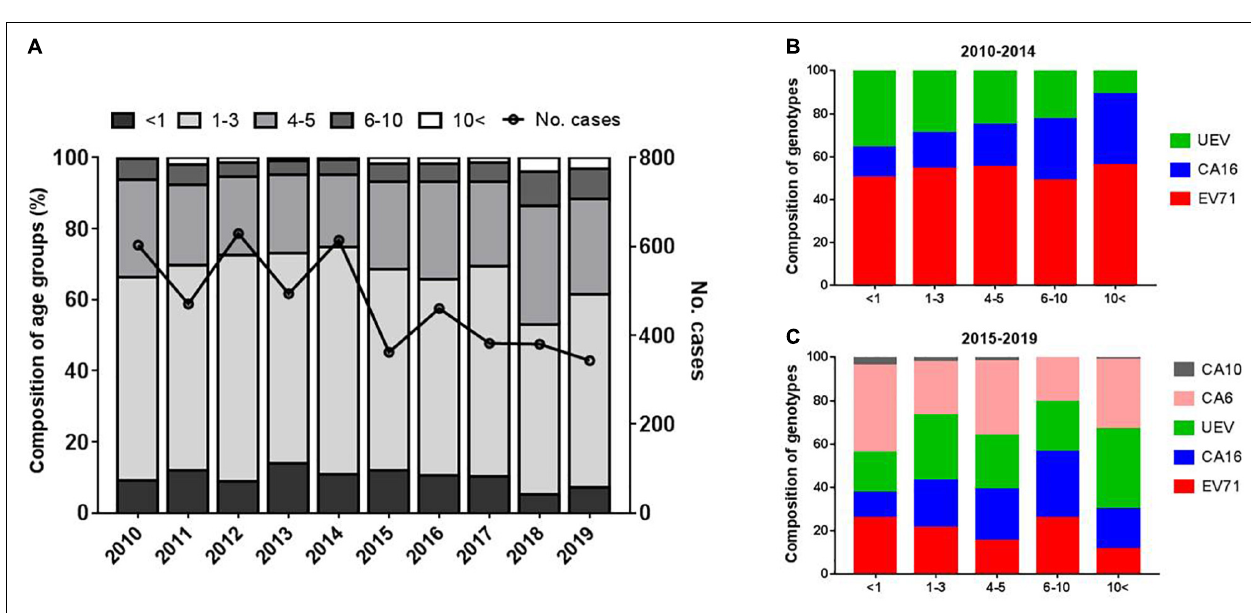
87,679 children were vaccinated as recorded, and about 26.4% of children under 3 years of age in Nanchang were vaccinated as of 2019 ( Supplementary Figure 2 ). Correlation analysis indicated that the EV-A71 vaccination was negatively correlated with the incidence of EV-A71 infection ( r = − 0.990, p = 0.01). The results indicated EV-A71 vaccination is effective in containing this virus in